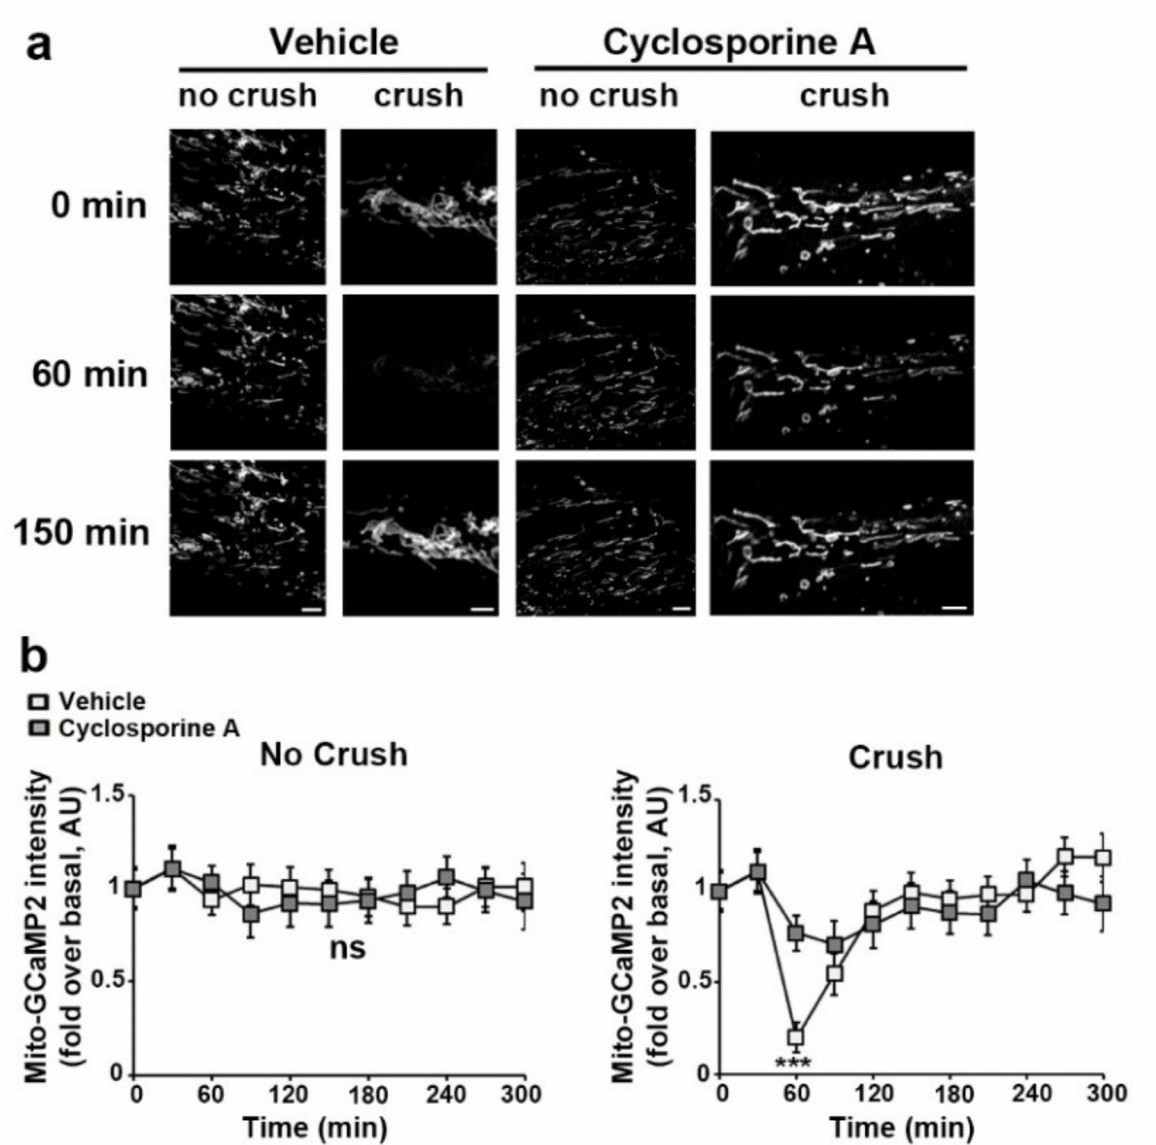
Figure 5. Blocking mPTP with cyclosporine A prevents mitochondrial calcium release in mSC following nerve injury. ( a ) Representative images of mSC mitochondria labeled with adenovirus- delivered mito-GCaMP2 probe in non-crushed (No Crush) and crushed (Crush) nerves at successive time points following treatment with 500 µ m cyclosporine A (right panels) or vehicle (left panels). Scale bar= 3 µ m. Same magnification for all pictures. ( b ) Left panel : Average fluorescence intensity of mito-GCaMP2 was measured for more than 100 mitochondria at successive time points in non- crushed nerves treated with cyclosporine A or vehicle. Right panel : Average fluorescence intensity of mito-GCaMP2 was measured for more than 100 mitochondria at the successive time points in crushed nerves treated with cyclosporine A or vehicle. The probe fluorescence intensity is normalized over the basal condition before crush or at the first imaging time point for non-crushed nerves. Error bars indicate SEM. Statistical tests are two-way ANOVA Sidak’s post hoc test comparing cyclosporine A and vehicle treated conditions. n = 3 animals for each condition. All mice were 8 to 11 weeks old. *** p <